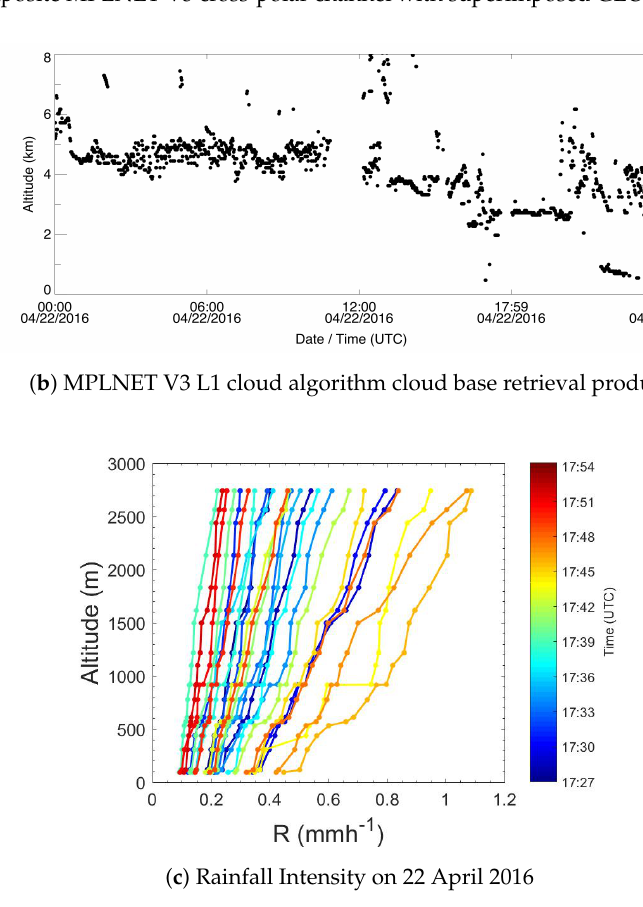
Figure 3. Vertically-resolved rainfall intensity computations at different measurement times for the GSFC MPLNET station on 22 April 2016. ( a ) MPL cross-polar channel signal; ( b ) cloud base height automatically retrieved by V3 L1 Cloud algorithm; ( c ) vertically-resolved rainfall intensities, computed with the analytical model solution using disdrometer data and V3 L1 cloud base height retrieval, from 5:27 p.m. UT to 5:54 p.m.